Question: What style of plot is this figure drawn as?
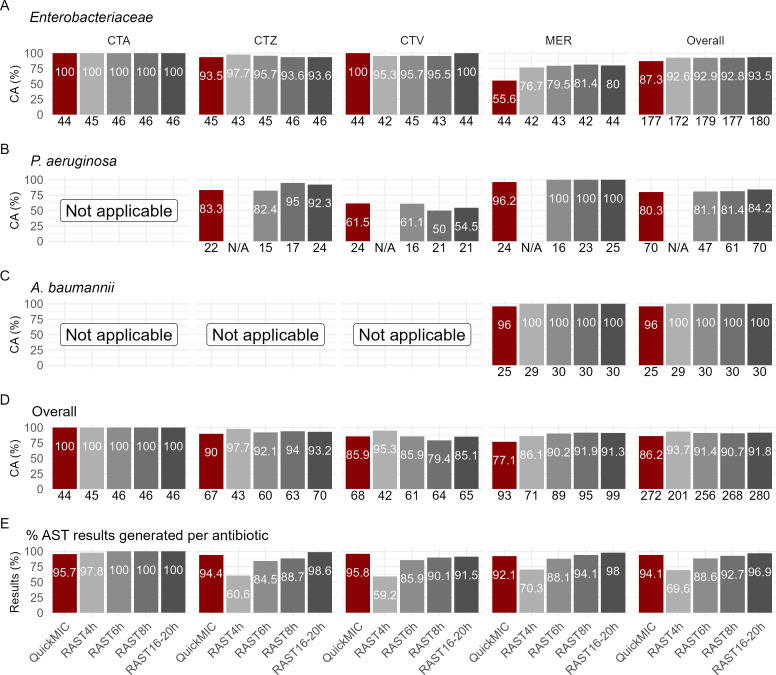
Answer: bar